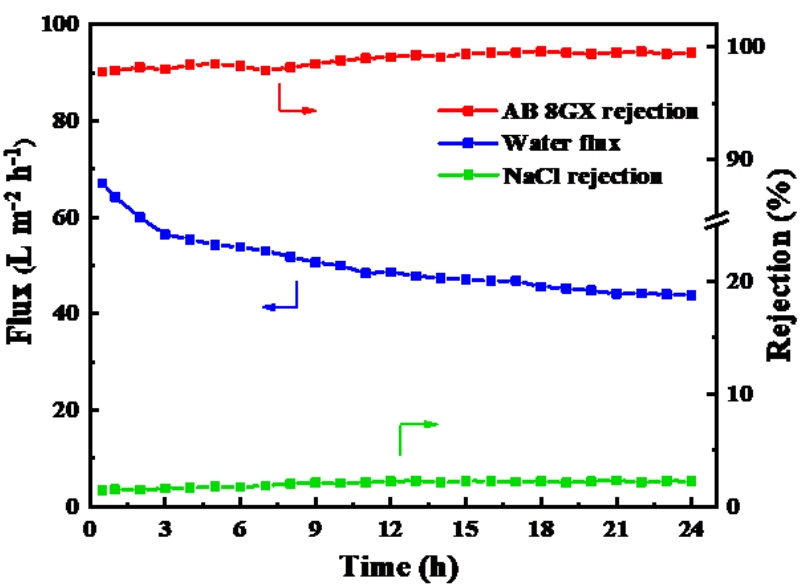
Figure 9. The long-time operation stability of PES/Fe-TA-PEI membranes for AB 8GX/NaCl mixture solution (feed: 0.1 g/L AB 8GX and 1 g/L NaCl). Table 2. Comparison of the performance of the NF membranes in the literatures.